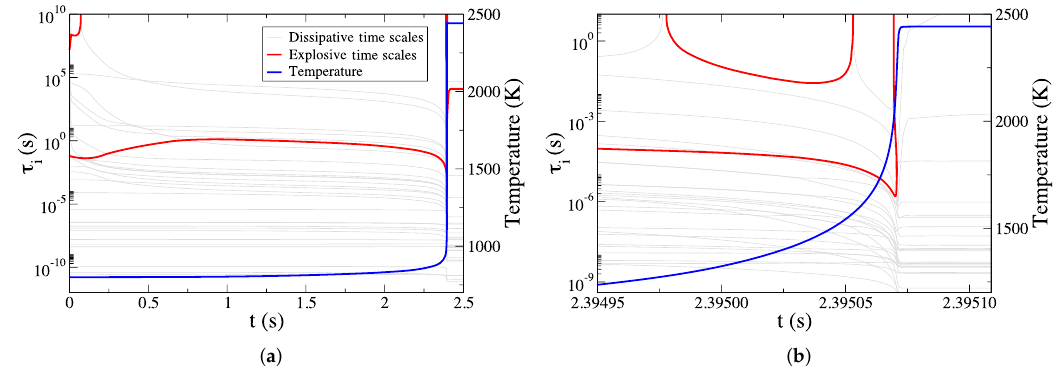
Figure 1. The developing dissipative (grey) and explosive (red) time scales for the case of pure NH 3 /air autoignition, overlaid with the evolution of temperature (blue): ( a ) the full explosive stage, ( b ) the final part of the explosive stage.